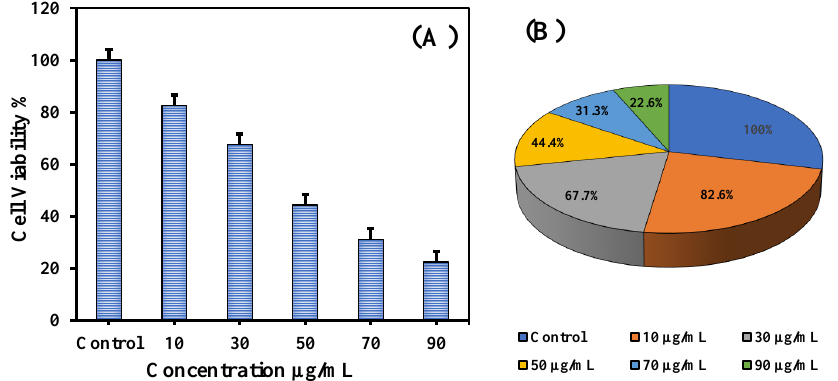
Figure 3. ( A ) Cytotoxicity of synthesized Ag NPs, ( B ) Pie chart of synthesized Ag NPs against cyto- toxicity.